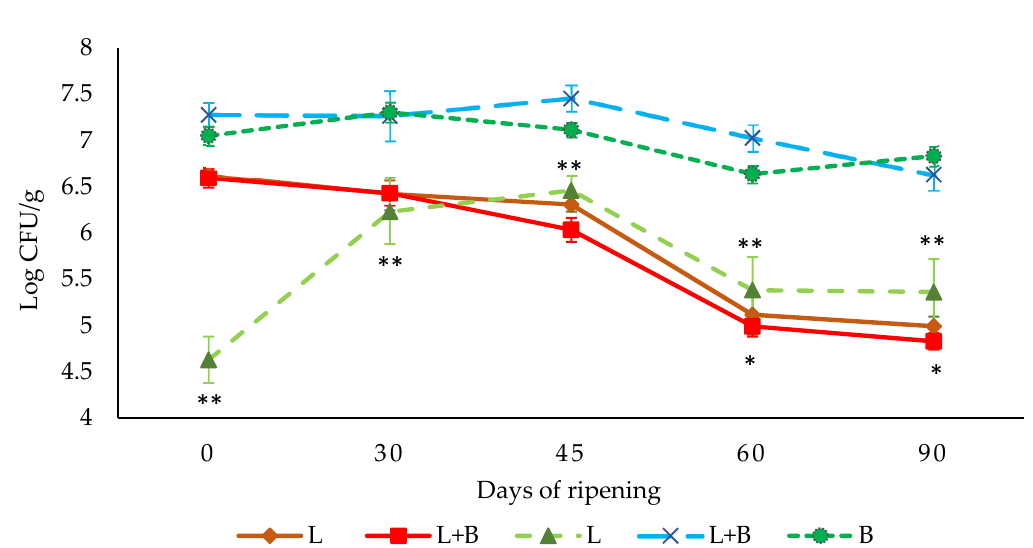
Figure 3. Growth curves of the LAB populations (dashed line) during the ripening process of dry-fermented sausages for batch B ( ● ), L ( ▲ ) and batch L + B (X) and L. monocytogenes populations (solid line) for batch L ( ♦ ) and batch L + B ( ▪ ). (*) indicates significant differences ( p ≤ 0.05) between batches of L. monocytogenes and (**) between batches of LAB.